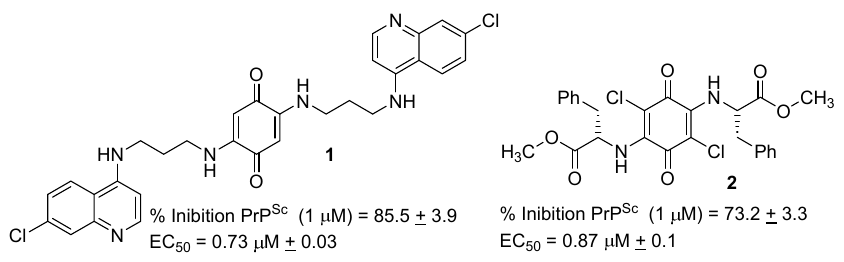
Figure 1. 2,5-Diamino-1,4-benzoquinone derivatives, containing aminoquinoline ( 1 ) and phenylalanine ( 2 ) moieties, with anti-prion activity [12,13].